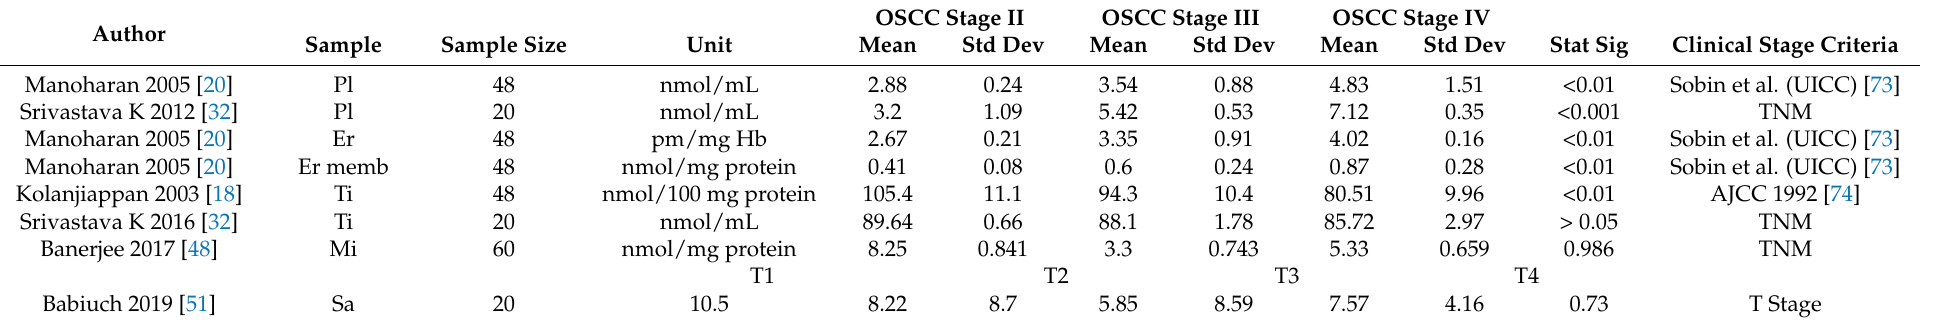
Table 3. The levels of MDA in various samples of patients with different clinical stages of